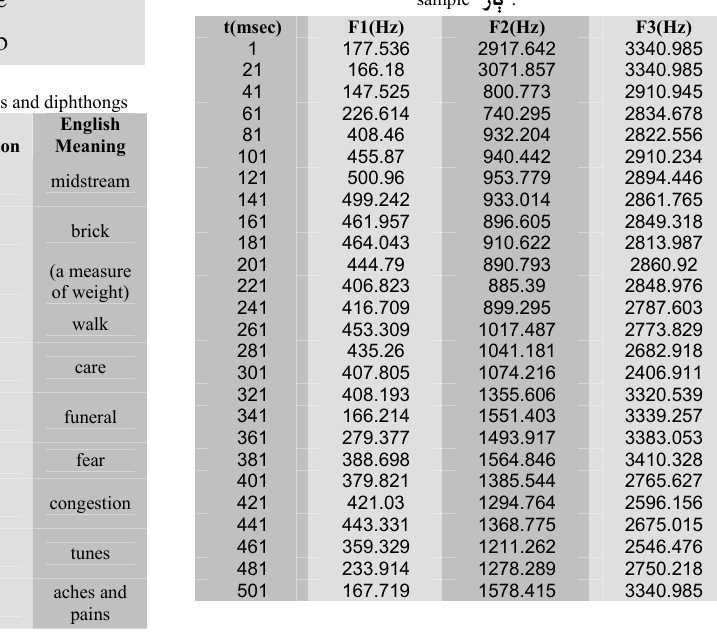
Table 9: Contents of the saved .frm file with formant values for the sample “ رﺌ(cid:125)َ